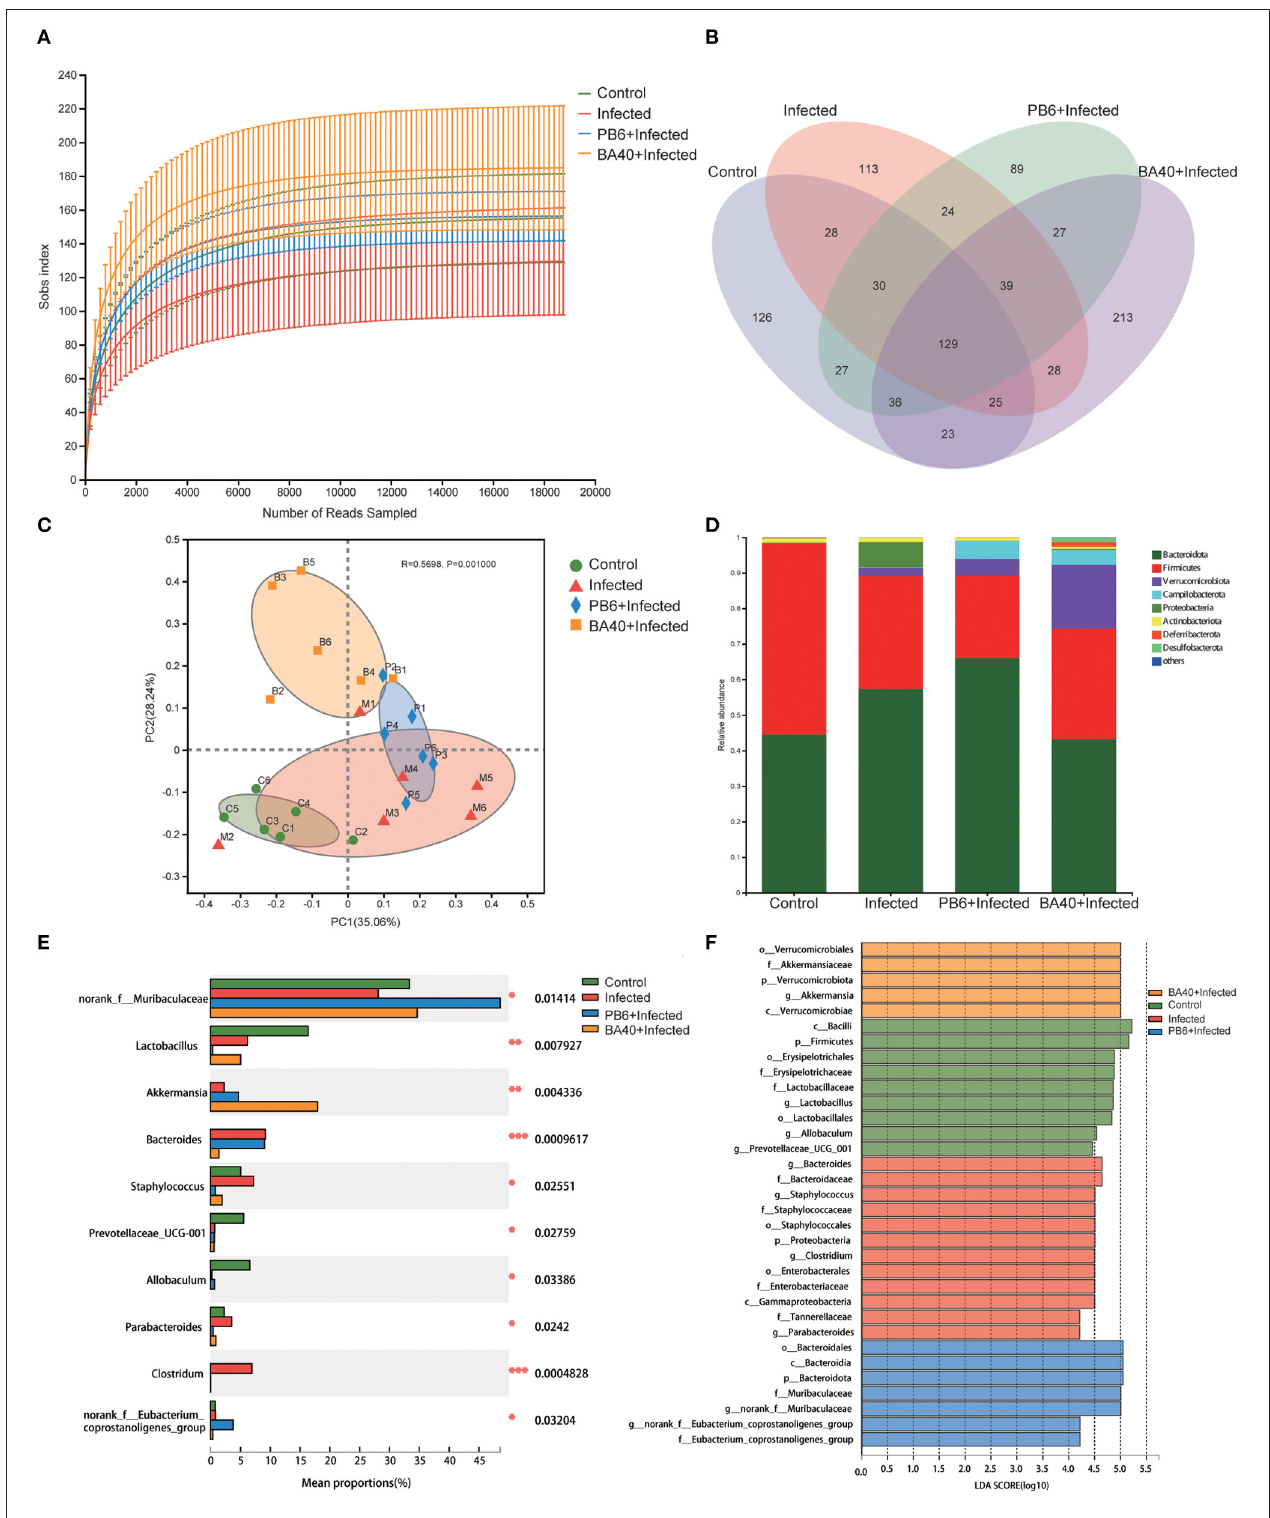
FIGURE 7 | BA40 reshapes the intestinal microbiota composition in C. perfringens -infected mice. (A) Observed ASV line chart. (B) Venn diagram. (C) Principal-component (PC) analyses. (D,E) Phylum-level (D) and genus-level (E) of the bacterial community in feces. (F) Linear discriminant analysis LDA scores ( > 4) computed for features at the amplicon sequence variance (ASV) level. Letters represented the taxonomy of the bacteria: p, phylum, c, class; o, order; f, family; g, genus. All results are expressed as mean ± SD in each group (* P < 0.05, ** P < 0.01, *** P < 0.01).